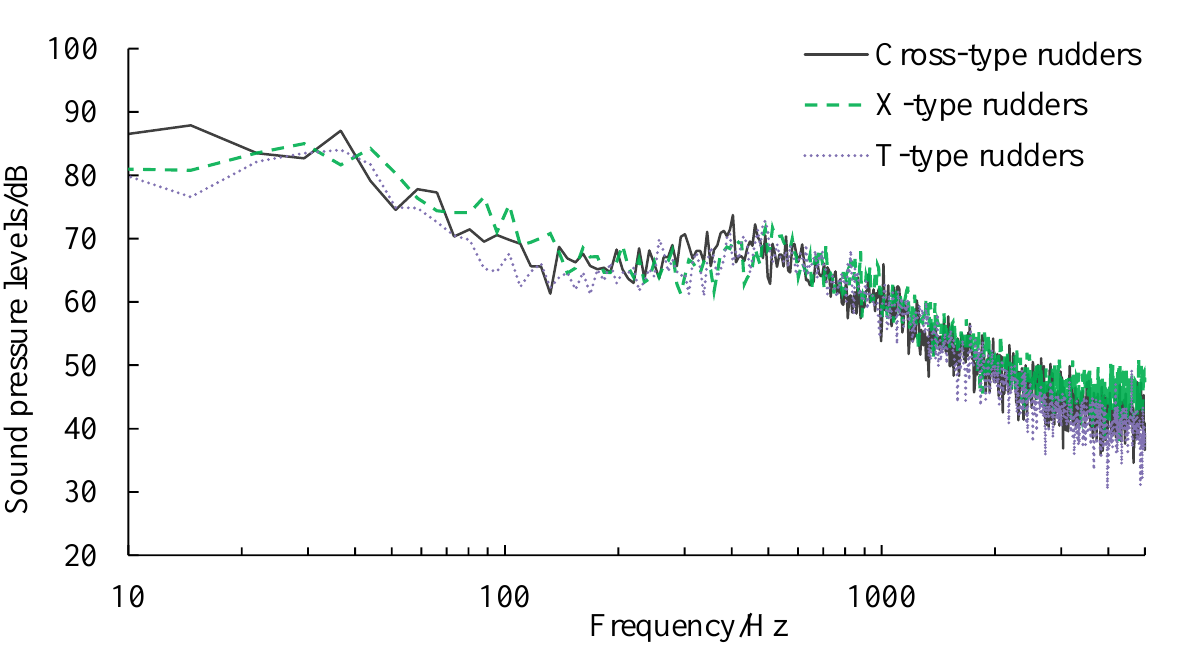
Figure 17. Spectrum of sound pressure level at characteristic point SZ9 of different underwater vehicles with full appendages.